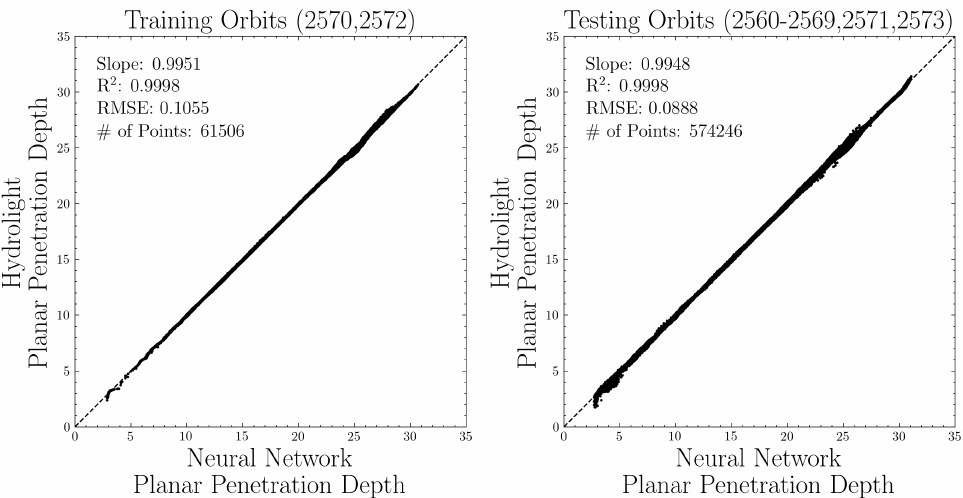
Figure 9. Comparisons of Hydrolight penetration depth simulations and neural network estimate for 7 January 2005. Left panel shows comparisons for orbits included in neural network training while right panel shows orbits on this date not included in the